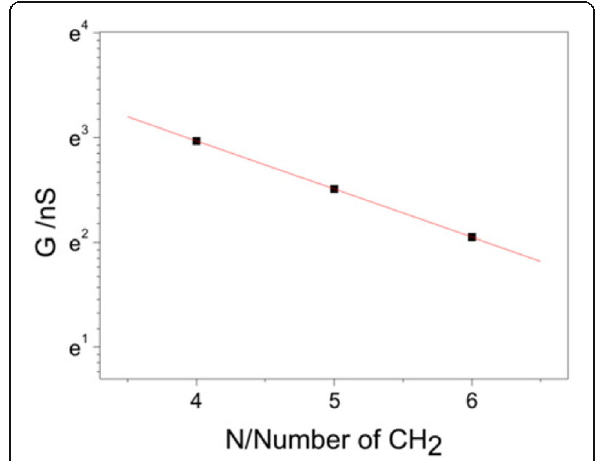
Fig. 5 Single-molecule conductance vs molecular length for iodine-terminated alkanes. Logarithmic plots of single-molecule conductance vs molecular length for iodine-terminated alkanes